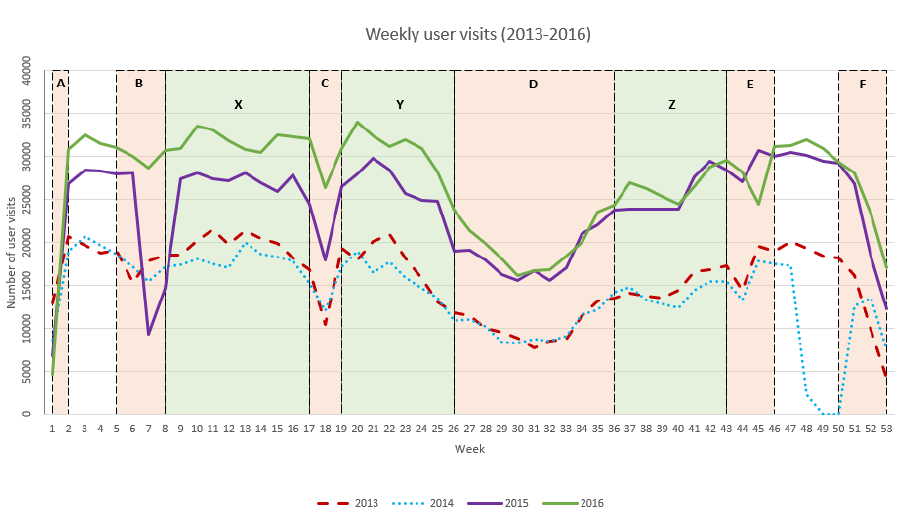
Figure 4. Weekly user visits to DLUM between January 2013 and December